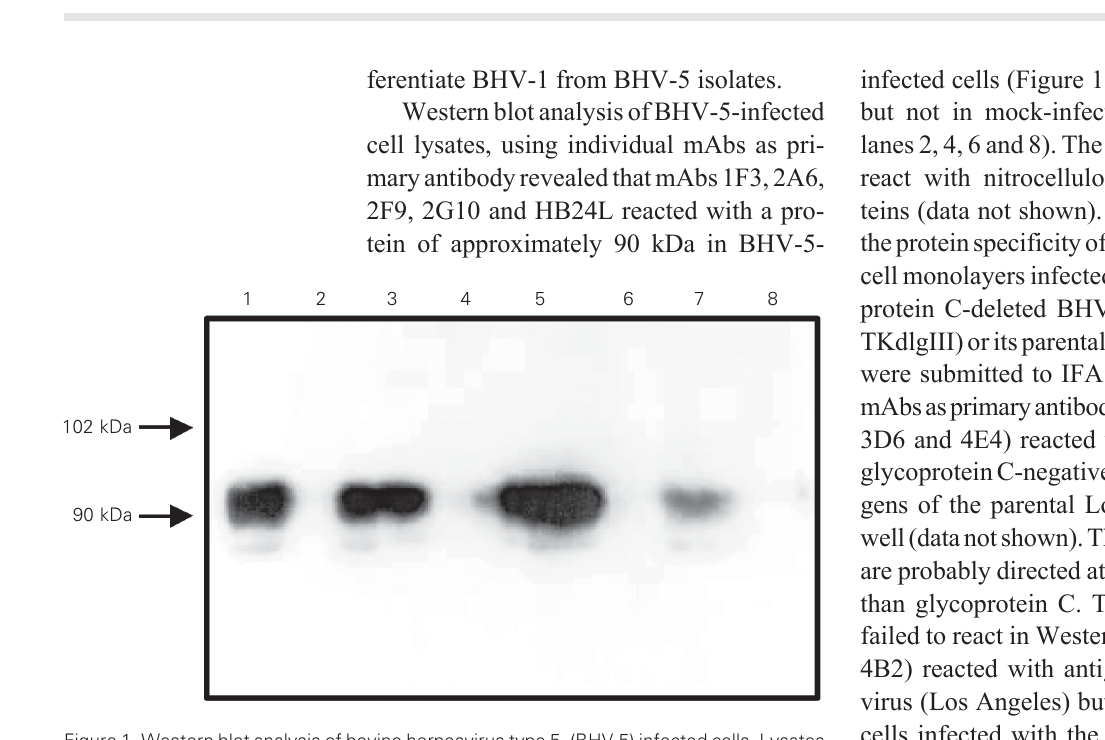
Figure 1. Western blot analysis of bovine herpesvirus type 5- (BHV-5) infected cells. Lysates of BHV-5-infected (lanes 1, 3, 5 and 7) or mock-infected (lanes 2, 4, 6 and 8) MDBK cells were resolved by SDS-PAGE and transferred to a nitrocellulose membrane. Viral proteins were detected using mAb 2F9 (1:1000 dilution, lanes 1 and 2), 1F3 (1:1000 dilution, lanes 3 and 4), HB24L (1:500 dilution, lanes 5 and 6) or 2G10 (1:200 dilution, lanes 7 and 8) followed by an anti-mouse IgG HRPO-conjugated antibody. The signal was detected by enhanced chemiluminescence using the Amersham detection kit. Arrows indicate the positions of the